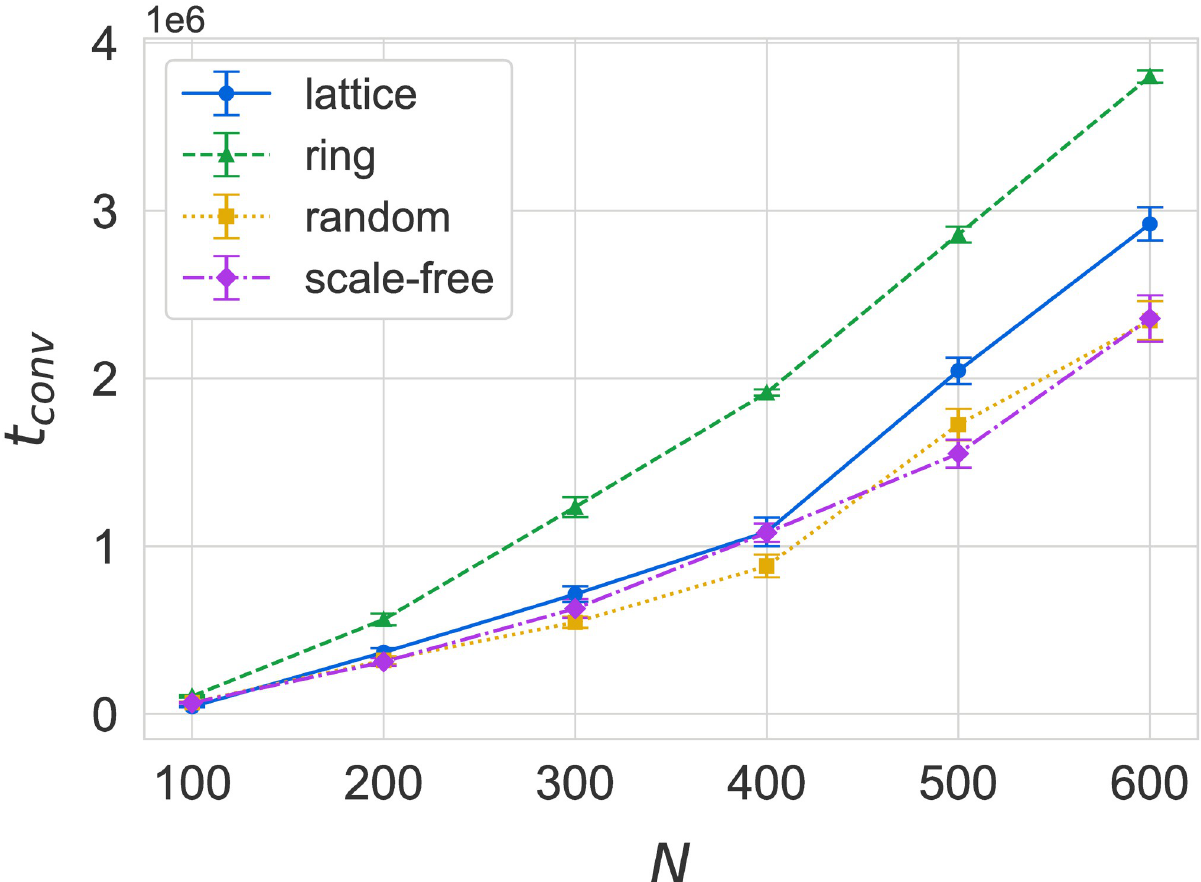
Fig 7. Scaling of convergence time t conv with population size N on different networks. Sharper increases in t conv correspond to larger average path lengths, although high clustering could also have an effect on ring graphs. Bars indicate standard